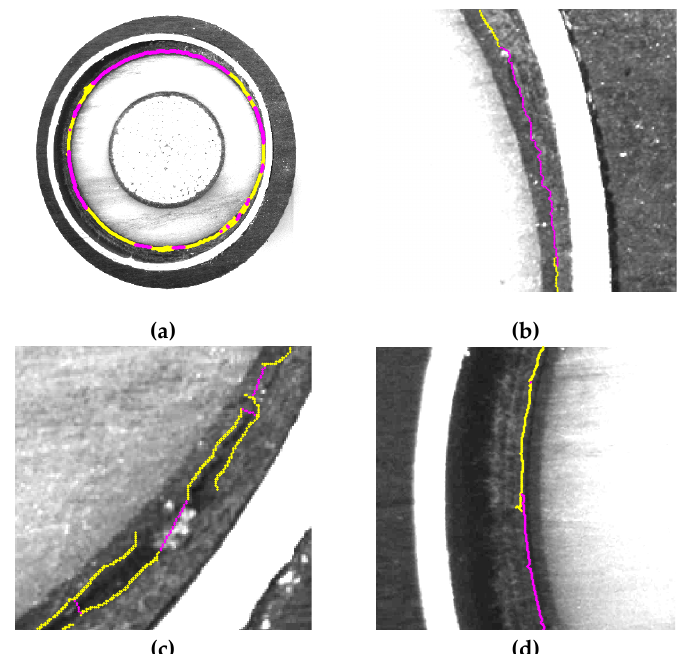
Figure 22. Edge 56 connection plotted on enhanced image. ( a ) Edge 56 connection, in which yellow dots Figure 22. (cid:1831)(cid:1856)(cid:1859)(cid:1857) (cid:2873)(cid:2874) connection plotted on enhanced image. (a) (cid:1831)(cid:1856)(cid:1859)(cid:1857) (cid:2873)(cid:2874) connection, in which yellow Figure 22. (cid:1831)(cid:1856)(cid:1859)(cid:1857) (cid:2873)(cid:2874) connection plotted on enhanced image. (a) (cid:1831)(cid:1856)(cid:1859)(cid:1857) (cid:2873)(cid:2874) connection, in which yellow are previous Edge 56 and magenta dots are connections; ( b ) Partial enlargement of ( a ) with accurate dots are previous (cid:1831)(cid:1856)(cid:1859)(cid:1857) (cid:2873)(cid:2874) and magenta dots are connections; (b) Partial enlargement of (a) with dots are previous (cid:1831)(cid:1856)(cid:1859)(cid:1857) (cid:2873)(cid:2874) and magenta dots are connections; (b) Partial enlargement of (a) with connections; ( c , d ) are partial enlargements of (a) with inaccurate Edge 56 in yellow. accurate connections; (c) and (d) are partial enlargements of (a) with inaccurate (cid:1831)(cid:1856)(cid:1859)(cid:1857) (cid:2873)(cid:2874) in yellow. accurate connections; (c) and (d) are partial enlargements of (a) with inaccurate (cid:1831)(cid:1856)(cid:1859)(cid:1857) (cid:2873)(cid:2874) in yellow. For contour refinement, one P-Mutation in initial C 45 and two P-Mutations in initial C 56 are For contour refinement, one P-Mutation in initial (cid:1829) (cid:2872)(cid:2873) and two P-Mutations in initial (cid:1829) (cid:2873)(cid:2874) are For contour refinement, one P-Mutation in initial (cid:1829) (cid:2872)(cid:2873) and two P-Mutations in initial (cid:1829) (cid:2873)(cid:2874) are detected by BDG algorithm and LTBC is made to these mutations. As shown in Figure 23a, yellow detected by BDG algorithm and LTBC is made to these mutations. As shown in Figure 23a, yellow detected by BDG algorithm and LTBC is made to these mutations. As shown in Figure 23a, yellow dots denote initial contour C 45 , red dots are refined contour after LTBC, and the inaccurate edges dots denote initial contour (cid:1829) (cid:2872)(cid:2873) , red dots are refined contour after LTBC, and the inaccurate edges dots denote initial contour (cid:1829) (cid:2872)(cid:2873) , red dots are refined contour after LTBC, and the inaccurate edges caused by cutting texture of XLPE insulation are detected as mutation and corrected. As shown in caused by cutting texture of XLPE insulation are detected as mutation and corrected. As shown in caused by cutting texture of XLPE insulation are detected as mutation and corrected. As shown in Figure 23b, yellow dots denote initial contour C 56 and the steep edges in busy background are detected Figure 23b, yellow dots denote initial contour (cid:1829) (cid:2873)(cid:2874) and the steep edges in busy background are Figure 23b, yellow dots denote initial contour (cid:1829) (cid:2873)(cid:2874) and the steep edges in busy background are as mutation and corrected. The inaccurate edges of C 56 are caused by inaccurate arc-based edge detected as mutation and corrected. The inaccurate edges of (cid:1829) (cid:2873)(cid:2874) are caused by inaccurate arc-based detected as mutation and corrected. The inaccurate edges of (cid:1829) (cid:2873)(cid:2874) are caused by inaccurate arc-based connection in busy background (Figure 22c,d), LTBC algorithm can fix mutations in Figure 22c to edge connection in busy background (Figure 22c,d), LTBC algorithm can fix mutations in Figure 22c edge connection in busy background (Figure 22c,d), LTBC algorithm can fix mutations in Figure 22c Figure 23b with circle characteristics and sequence continuity, but inaccurate edges with gentle changes to Figure 23b with circle characteristics and sequence continuity, but inaccurate edges with gentle to Figure 23b with circle characteristics and sequence continuity, but inaccurate edges with gentle in radial direction (Figure 22d) are failed to be corrected. For other layers without break detected, it changes in radial direction (Figure 22d) are failed to be corrected. For other layers without break changes in radial direction (Figure 22d) are failed to be corrected. For other layers without break means good consistency of points in the detected, it means good consistency of points in the contour. detected, it means good consistency of points in the contour.